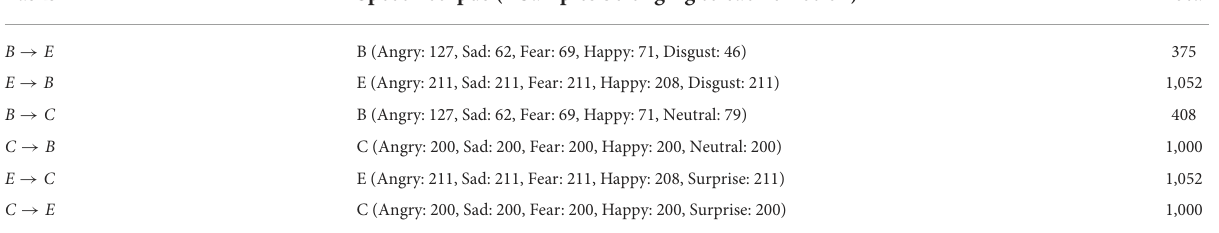
TABLE 1 The sample statistics of EmoDB (B), eNTERFACE (E), and CASIA (C) corpora used in the designed six cross-corpus SER tasks.